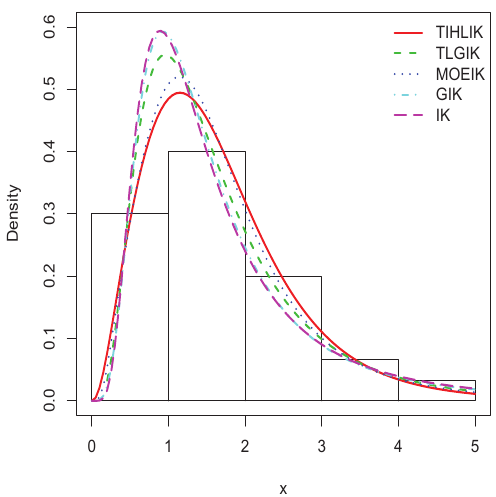
Figure 13. Plots of the estimated pdfs for data set 1.